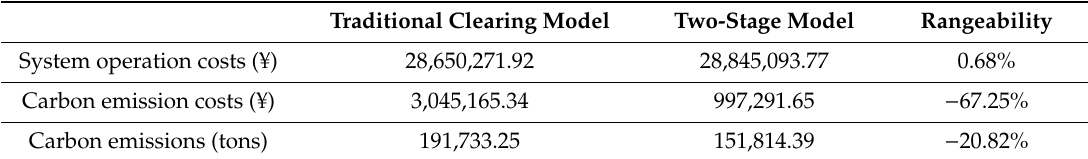
Table 3. Comparison of results between two optimization models.